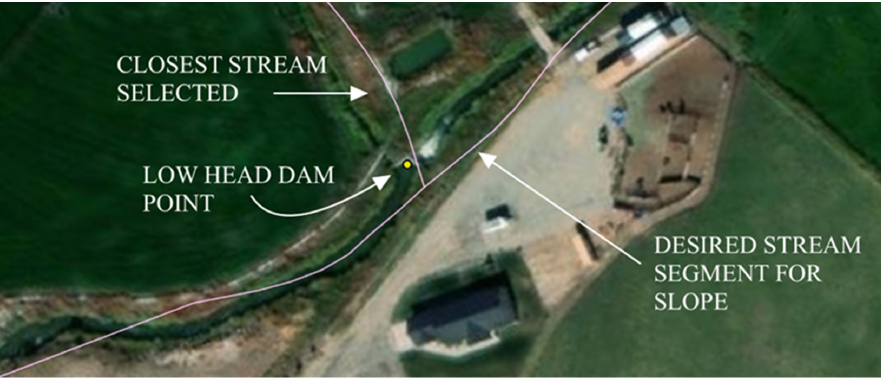
Figure 6. Example of a stream selection error for a low head dam with no fatalities in Idaho.